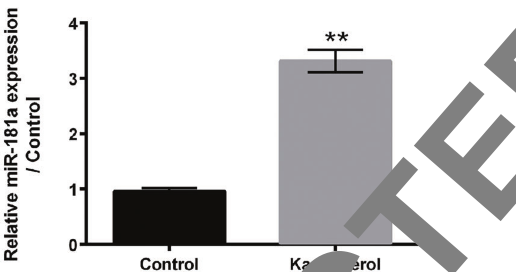
Figure 5. Kaempferol up-regulated the expression of microRNA (miR)-181a in SNU-216 cells. Quantitative reverse transcription PCR was conducted to determine the expression of miR-181a in SNU-216 cells after 50 m M kaempferol treatment. Data are reported as means ± SD. **P o 0.01 ( t -test).